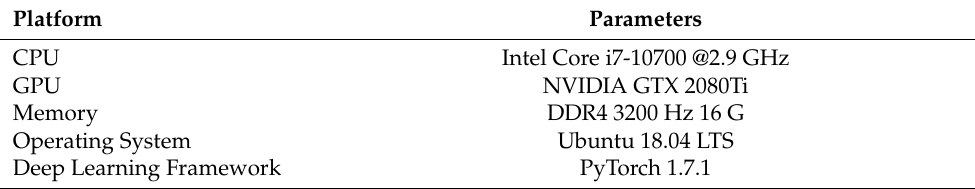
Table 1. The software and hardware platform required for Transformer algorithm.